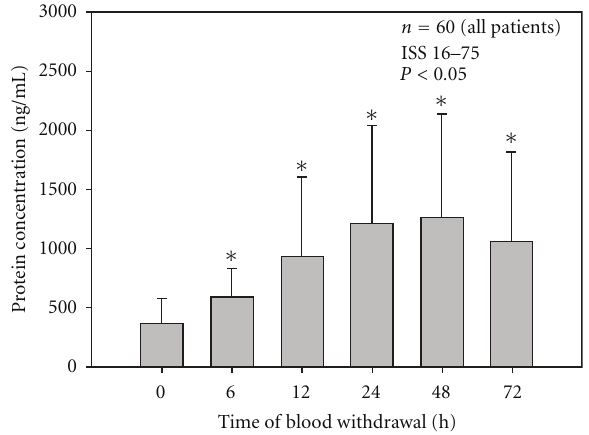
Figure 2: Significant increase of mean TIMP-1 serum concentra- tion levels 6h–72 h after the traumatic event compared to initial mean TIMP-1 serum level at 0 h after trauma. Data were analyzed by Mann-Whitney Rank Sum test and presented by mean ± standard error of the mean ( ∗ P < 0 . 05).